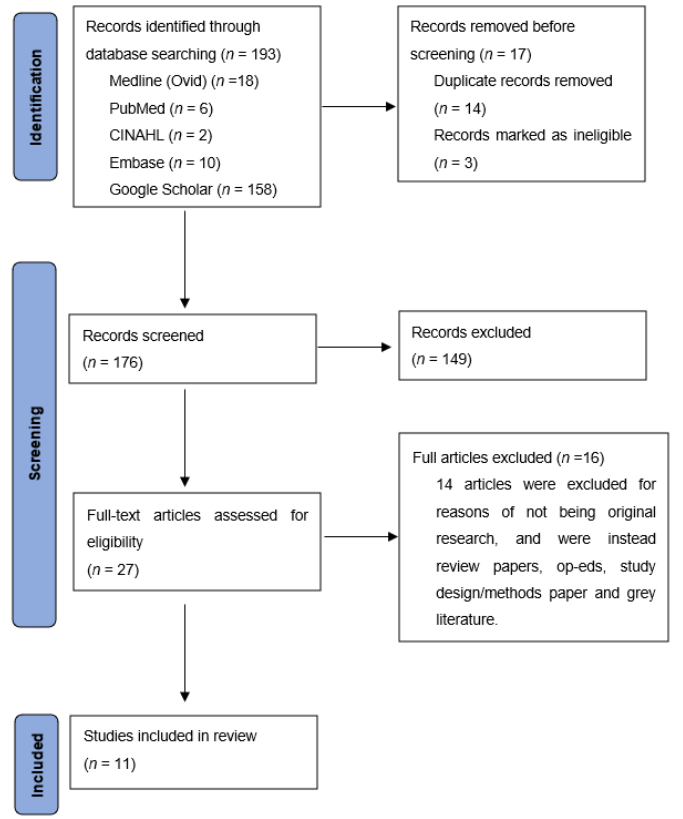
Figure 1. PRISMA flowchart. Adapted from [26] .